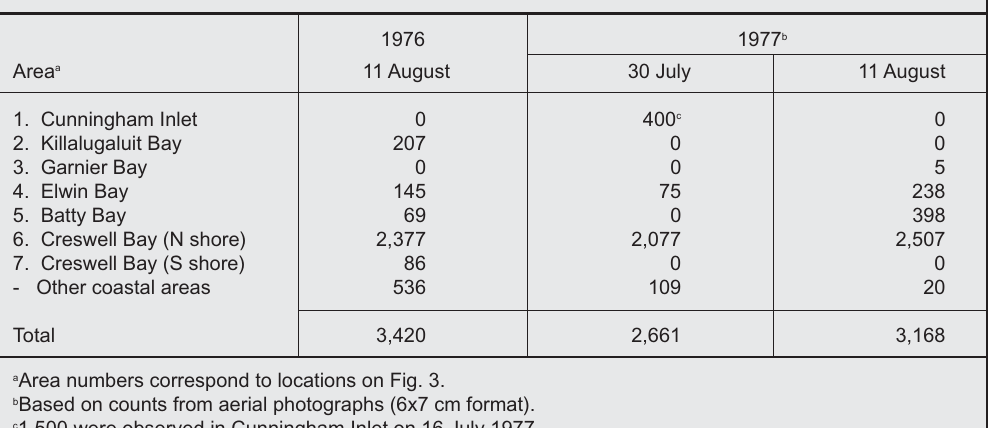
Table 6. Distribution of belugas along the north and east coasts of Somerset Island, 1976 and